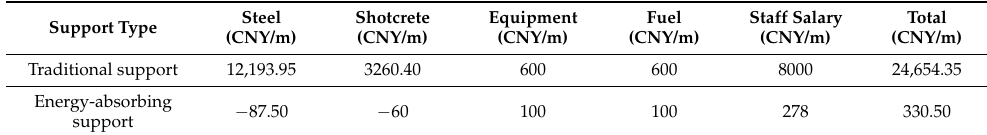
Table 7. Comparison of extra costs.